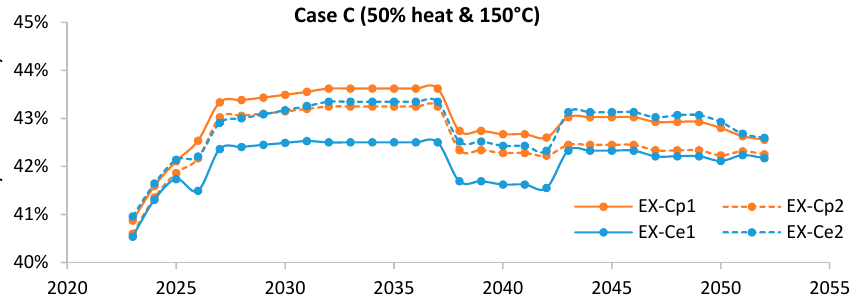
Figure 9. Performances of extraction steam turbine cycles defined for case C.